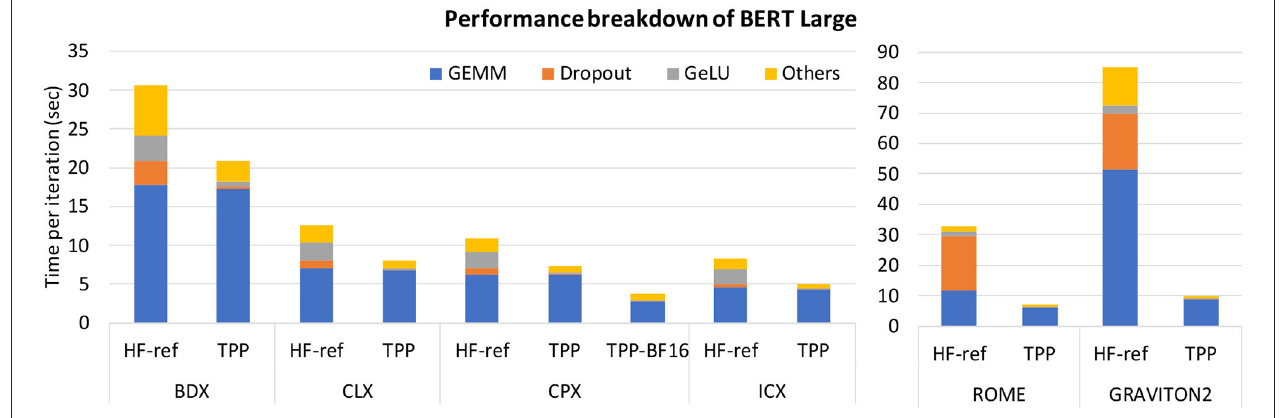
FIGURE 26 | BERT large performance breakdown on multiple